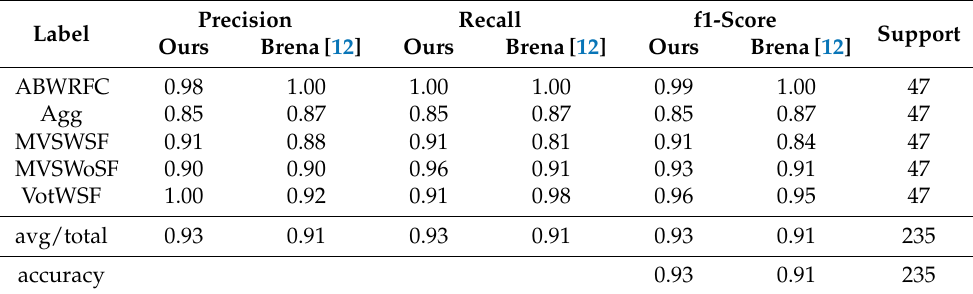
Table 6. Fusion strategies identification (RFC-based performance